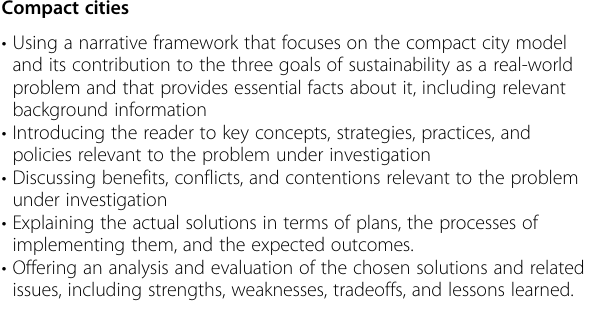
Table 1 A five-step process tailored to each of the four case studies conducted Compact